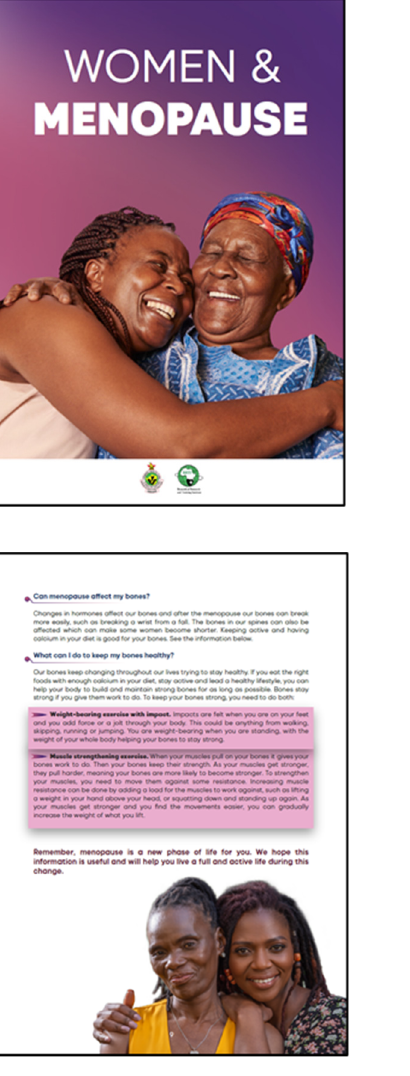
Figure 4. Final designs in Zimbabwe.